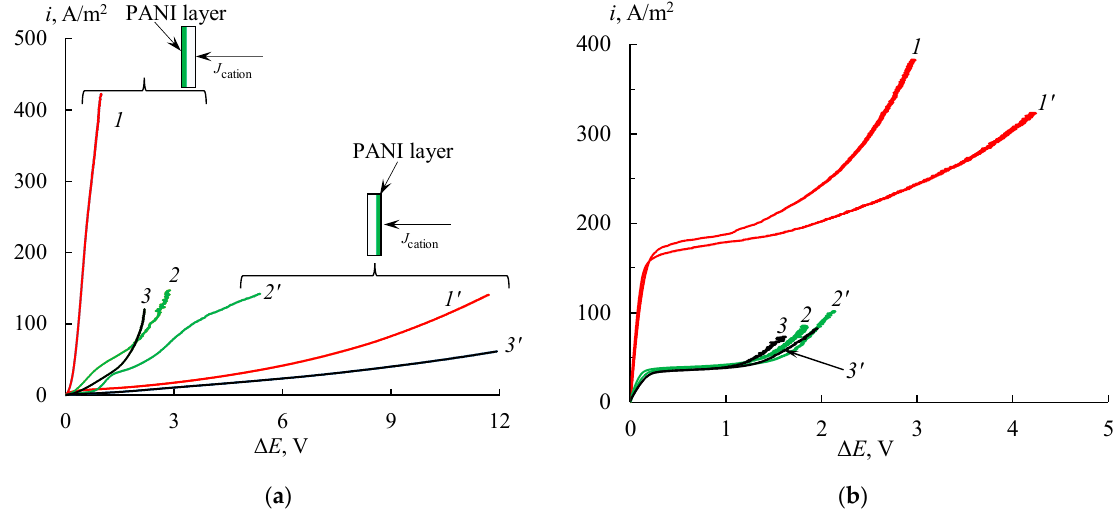
Figure 7. CVCs of modified MF-4SK/PANI ( a ) and MK-40/PANI ( b ) in 0.05 mol-eq/L HCl (1, 1 ′ ), NaCl (2, 2 ′ ) and CaCl 2 (3, 3 ′ ). The composite is faced with the non-modified surface (1, 2, 3) and PANI layer (1 ′ , 2 ′ , 3 ′ ) to the counter-ions flow.